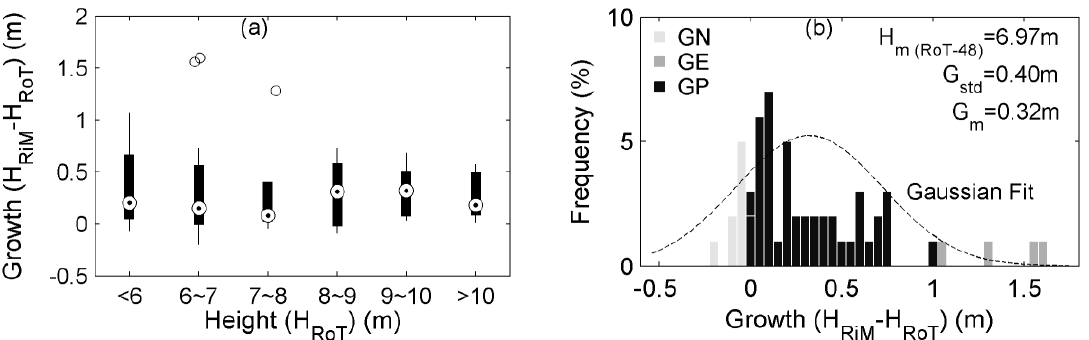
Figure 4. Boxplots ( a ) and histogram ( b ) of the reference one-year height growths derived from the RoT and RiM data collections. See text for the definition of